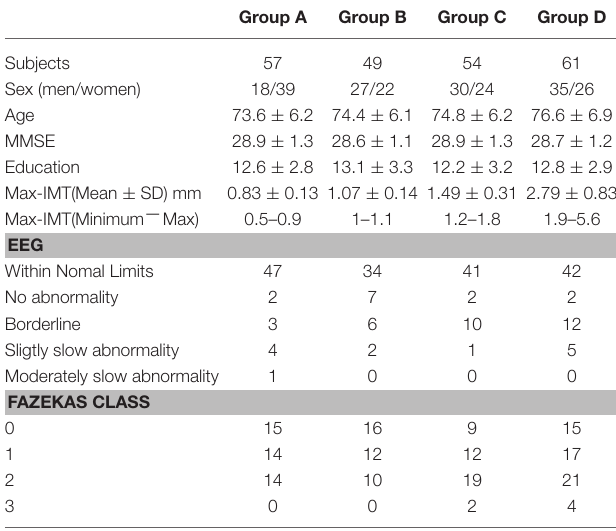
TABLE 1 | Clinical and radiological characteristics of the study